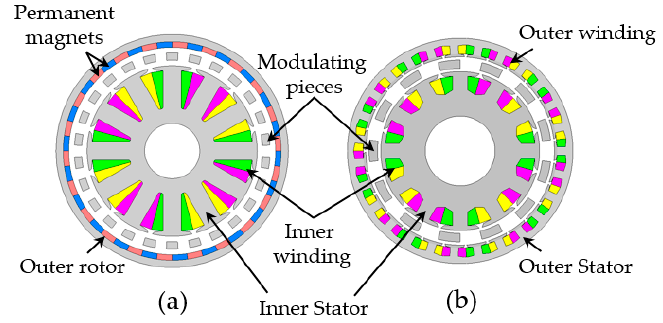
Figure 1. Basic structure: ( a ) Magnetic geared motor; ( b ) Doubly Fed Magnetic geared motor